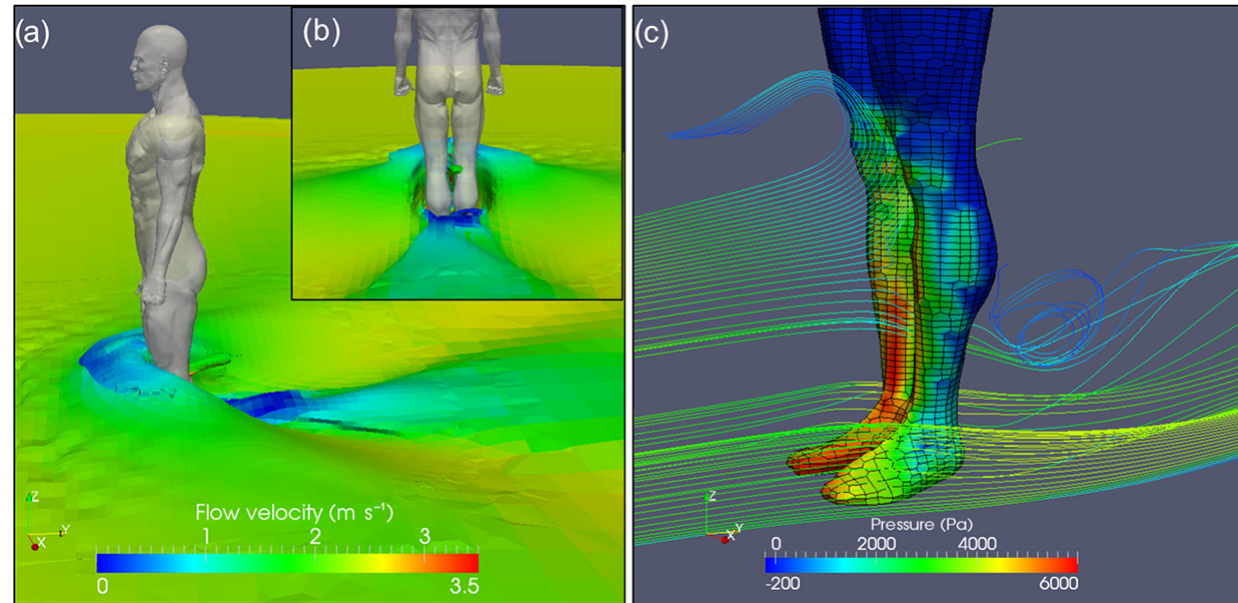
Figure 3. Splashing effect for super-critical flows shown as flow velocity (a) , streamlines (c) and inset view parallel to flow direction upstream-oriented (b) , for the subject tested by Jonkman and Penning-Rowsell (2008), H = 0 . 35m, U = 2 . 40ms − 1 . Panel (c) also shows the pressure distribution on the feet and the legs of the